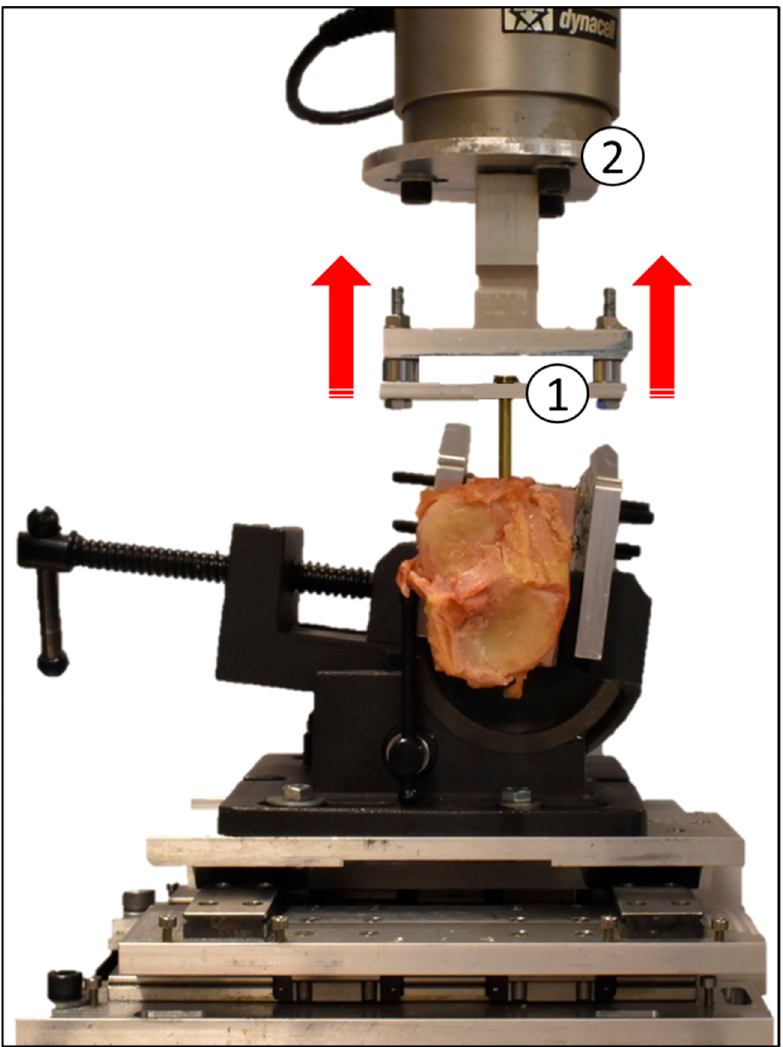
Figure 4. Mechanical testing for screw pull-out strength (POS), in which the screw is pulled through the custom-made fixture (1) and attached to the load cell (2) while the bone, supported by a system of rails, is free to move in the X-Y plane.